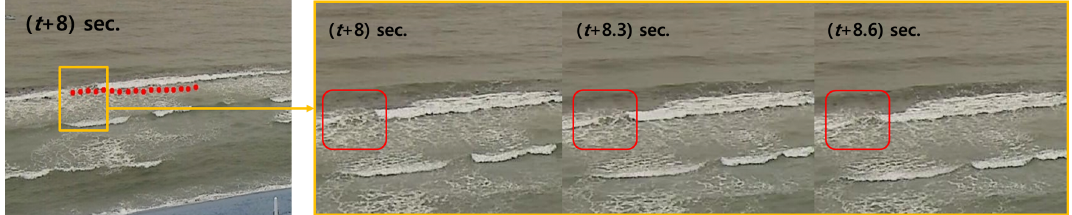
Figure 7. Successive images at ( t + 8) s., ( t + 8.3) s., and ( t + 8.6) s. causing inaccuracy in tracking the 4 landmarks on the left side of Figure 6c with an indefinite wave crest against propagating waves in red square region.